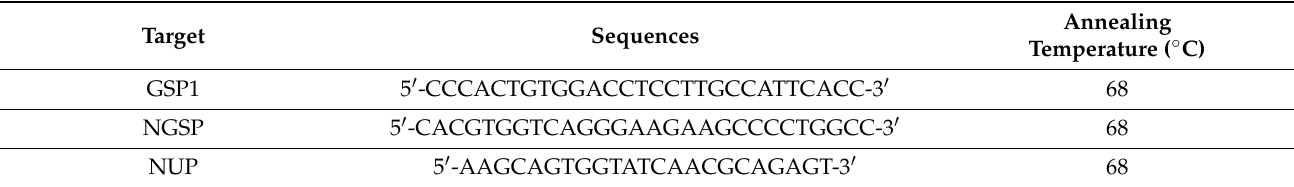
Table 3. Primers used to perform